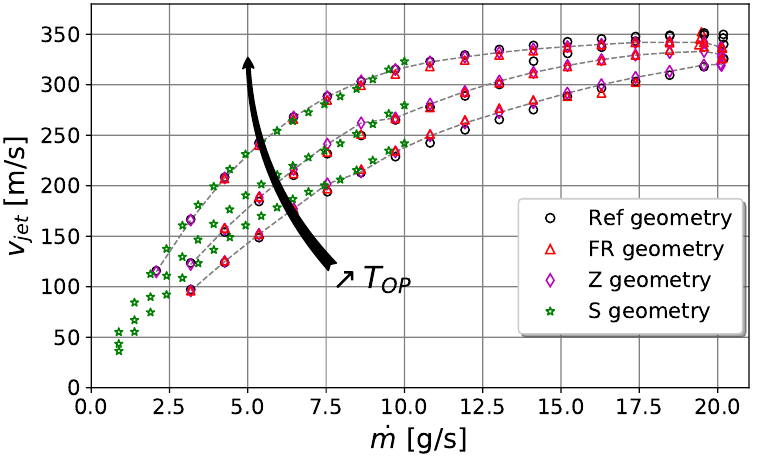
Figure 10. Relation between mass flow rate, outlet velocity and throttling ratio for different FO- PJA